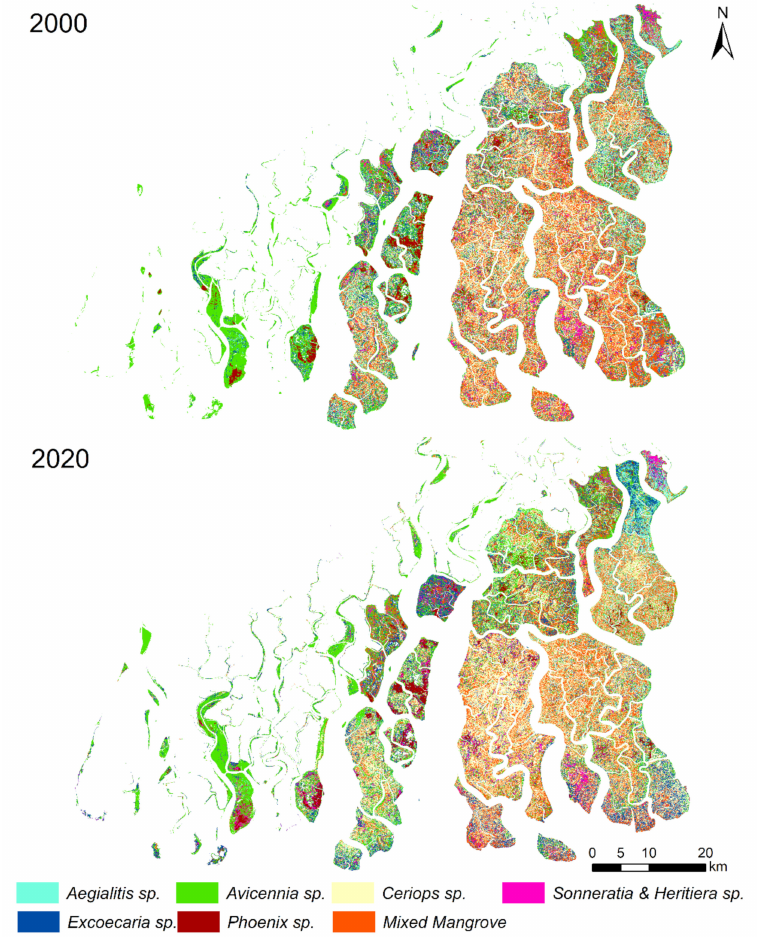
Figure 3. Distribution of dominant mangrove communities of the Indian Sundarbans in 2000 and